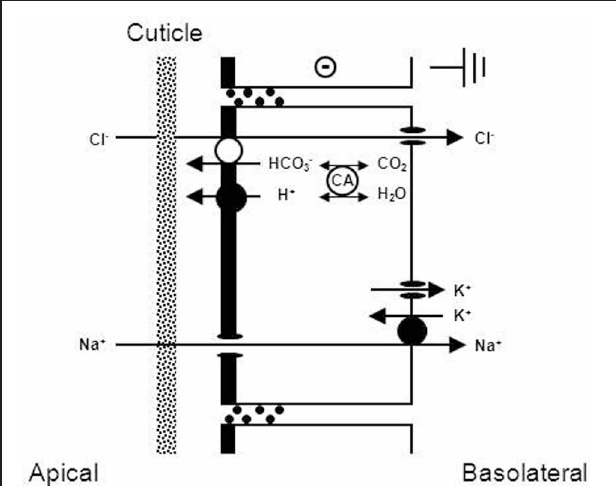
FIGURE 6 | Transport mechanism proposed for transbranchial NaCl absorption across the gills of hyperosmoregulators characterized by a low conductance (“tight”) epithelium (after Onken and Riestenpatt, 1998). Active, Cl − independent Na + absorption proceeds via epithelial, amiloride-sensitive Na + channels (ENAC) in the apical membrane and the Na + /K + -ATPase in the basolateral membrane. Active, Na + independent Cl − absorption proceeds via apical Cl − /HCO − 3 exchangers and basolateral Cl − channels. Cytoplasmic carbonic anhydrase (CA) supports both Na + and Cl − transport. Basolateral K + channels generate a negative electrical potential in the cells. An apical V-type H + -pump increases intracellular HCO − 3 , supporting transapical Cl − absorption. Moreover, the electrogenic nature of the H + -pump hyperpolarizes the intracellular negativity, supporting the entry of Na + ions across the apical membrane and the exit of Cl − ions across the basolateral membrane.